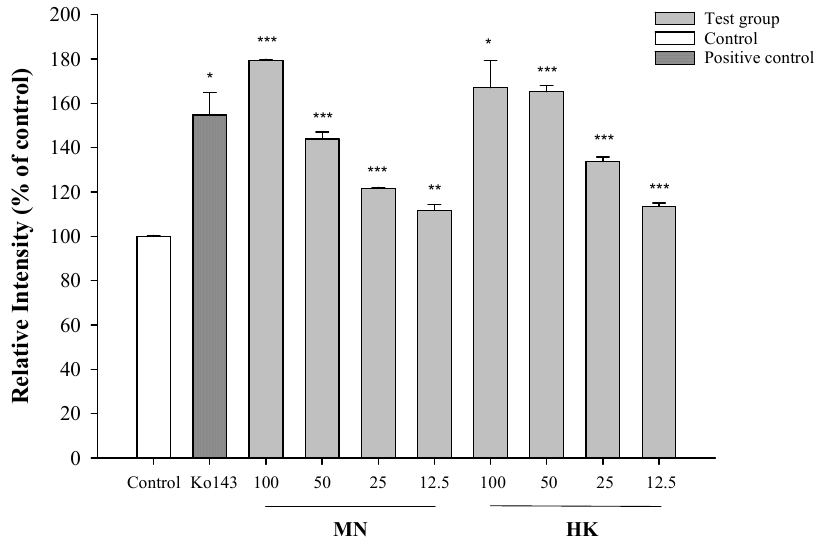
Figure 2. Effects of MN (µM), HK (µM) and Ko143 (0.25 µM, a positive control of BCRP inhibitor) on the intracellular accumulations of MXR in MDCKII-BCRP cells by using flow cytometry method. * p < 0.05, ** p < 0.01, *** p < 0.001. Control: 0.01% DMSO in reaction buffer.